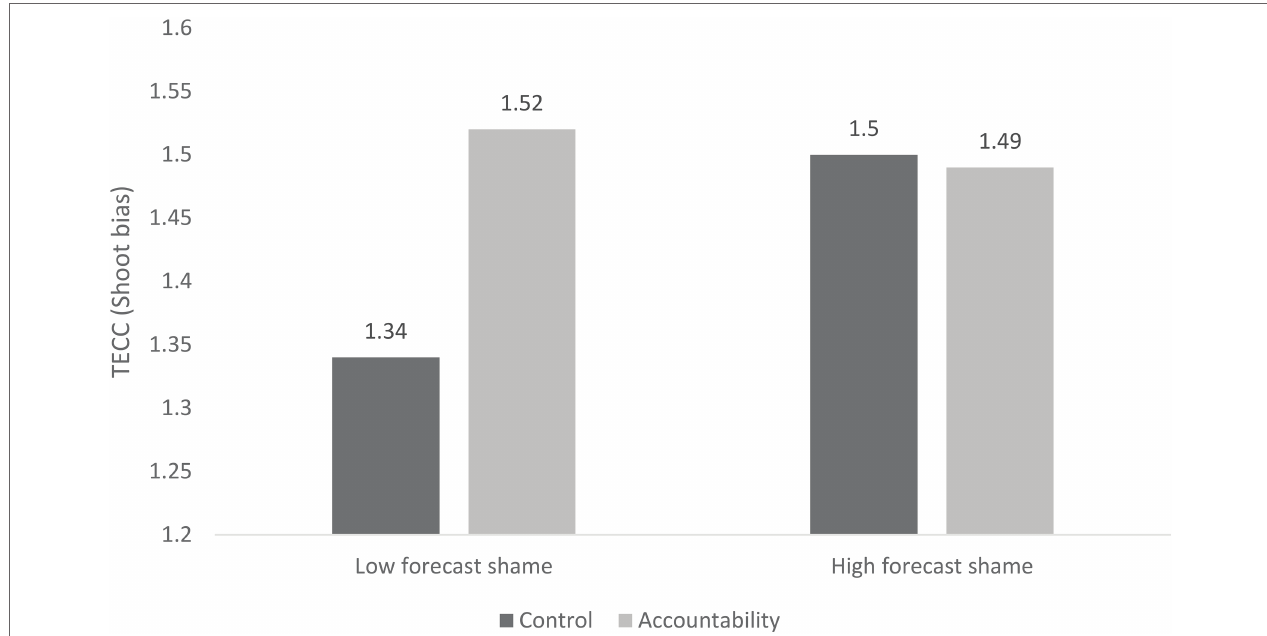
FIGURE 1 | Interaction between forecast group-based shame and accountability predict tolerance of enemy collateral casualties as decision-making bias in Study